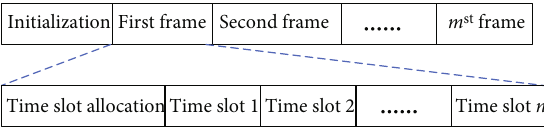
Figure 5: Initial time slot allocation.